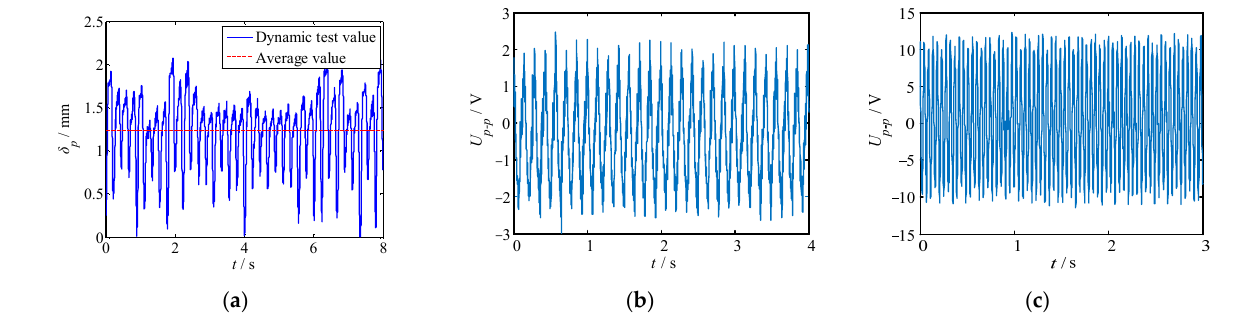
Figure 11. MFC displacement and continuous voltage response of the piezoelectric generator. ( a ) MFC displacement; ( b ) continuous voltage at R = 10 k Ω , f = 10 Hz; ( c ) continuous voltage at R = 40 k Ω , f = 25